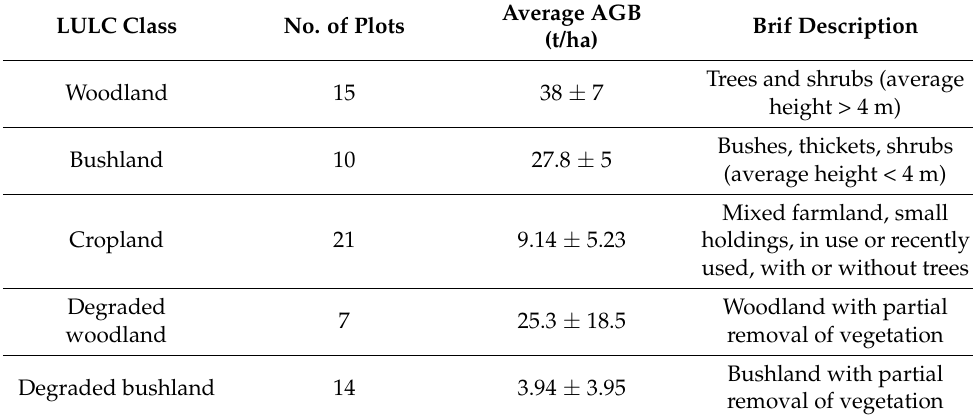
Table 2. LULC classes and AGB stock data used in the AoIs in northern Uganda. LULC Class No. of